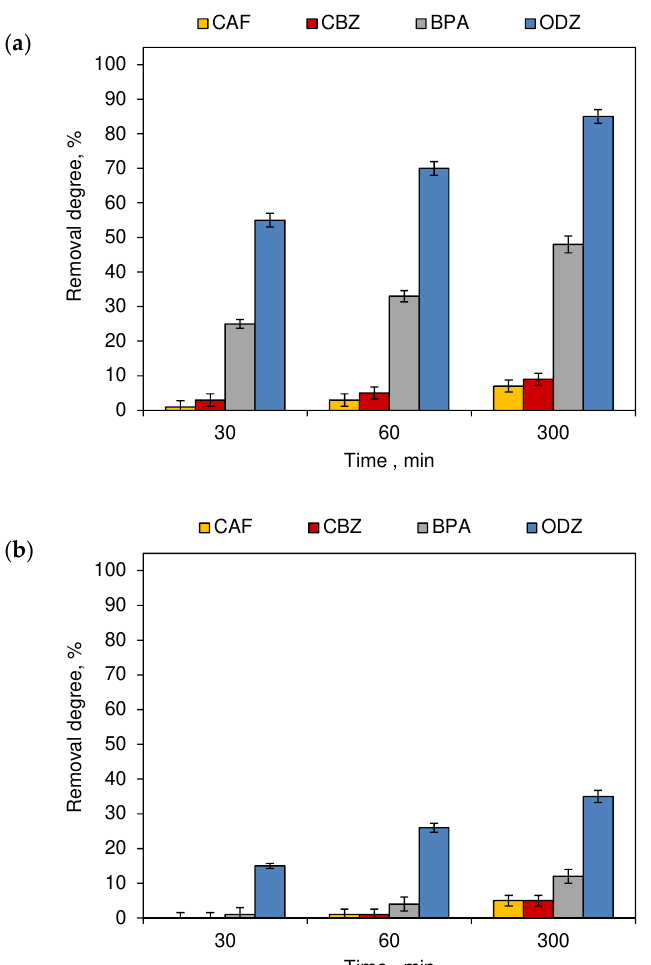
Figure 5. The removal degree of CECs tap water mixtures exposed to ( a ) sunlight (outdoor swimming pool) and ( b ) artificial lighting (indoor swimming pool) ( n = 3; where CAF—caffeine, CBZ—carbamazepine, BPA—bisphenol A, ODZ—oxadiazon).